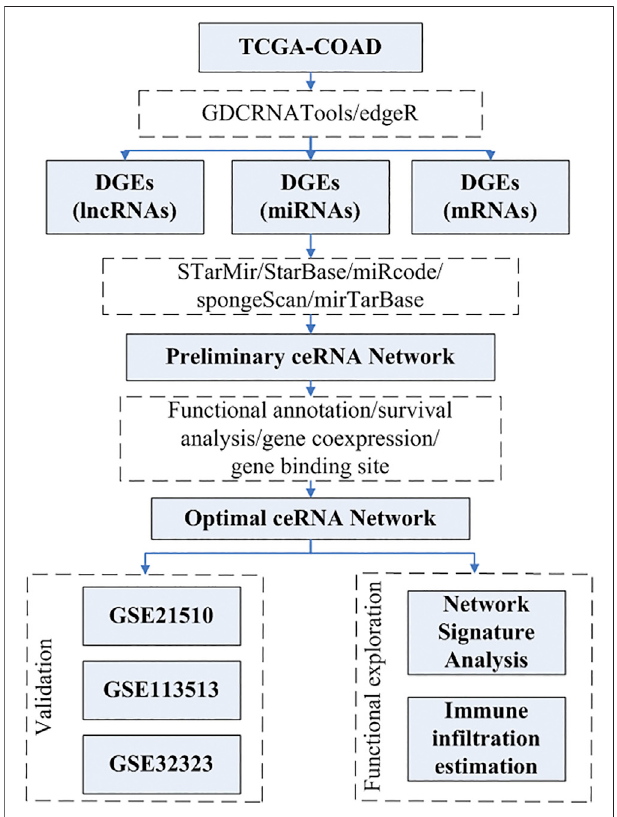
FIGURE 1 | Flowchart of the research